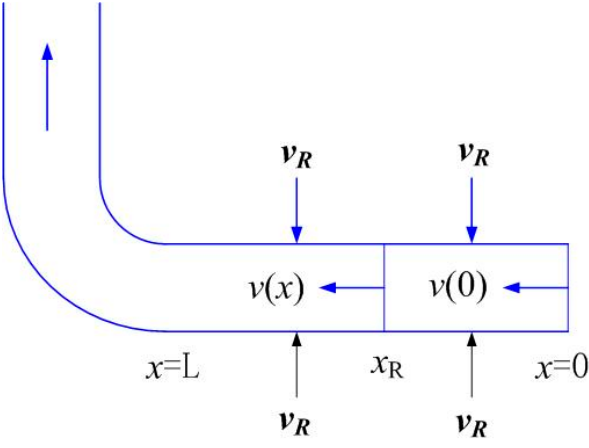
Figure 3. Sketch map of horizontal wellbore flow.